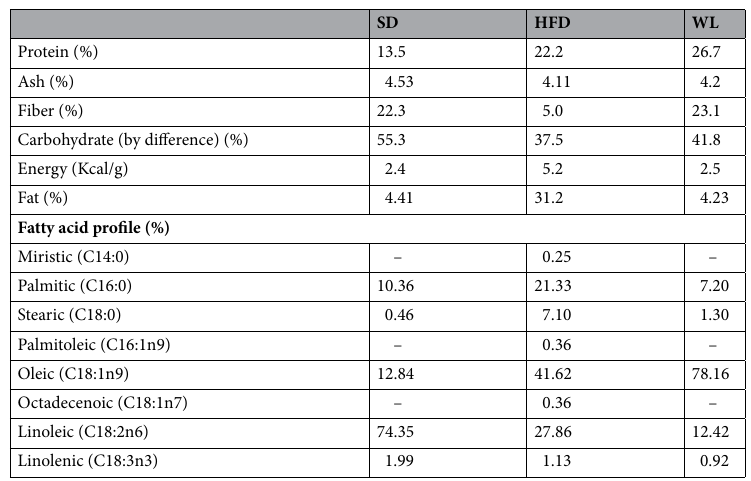
Table 5. Nutrient composition of the experimental diets. SD standard rat chow, HFD hypercaloric diet for dietary induction of obesity, WL high protein intervention diet for weight loss. Formulation of WL diet per 100 g: pea protein isolate 21%, whey protein isolate 18%, cysteine 0.2%, olive oil 4%, Cellulose 11%, Plantago ovata fiber 11%, AIN93M mineral premix 3.5%, AIN93M vitamin premix 1%, coline bitartrate 0.25%, dextrins 15%, wheat starch